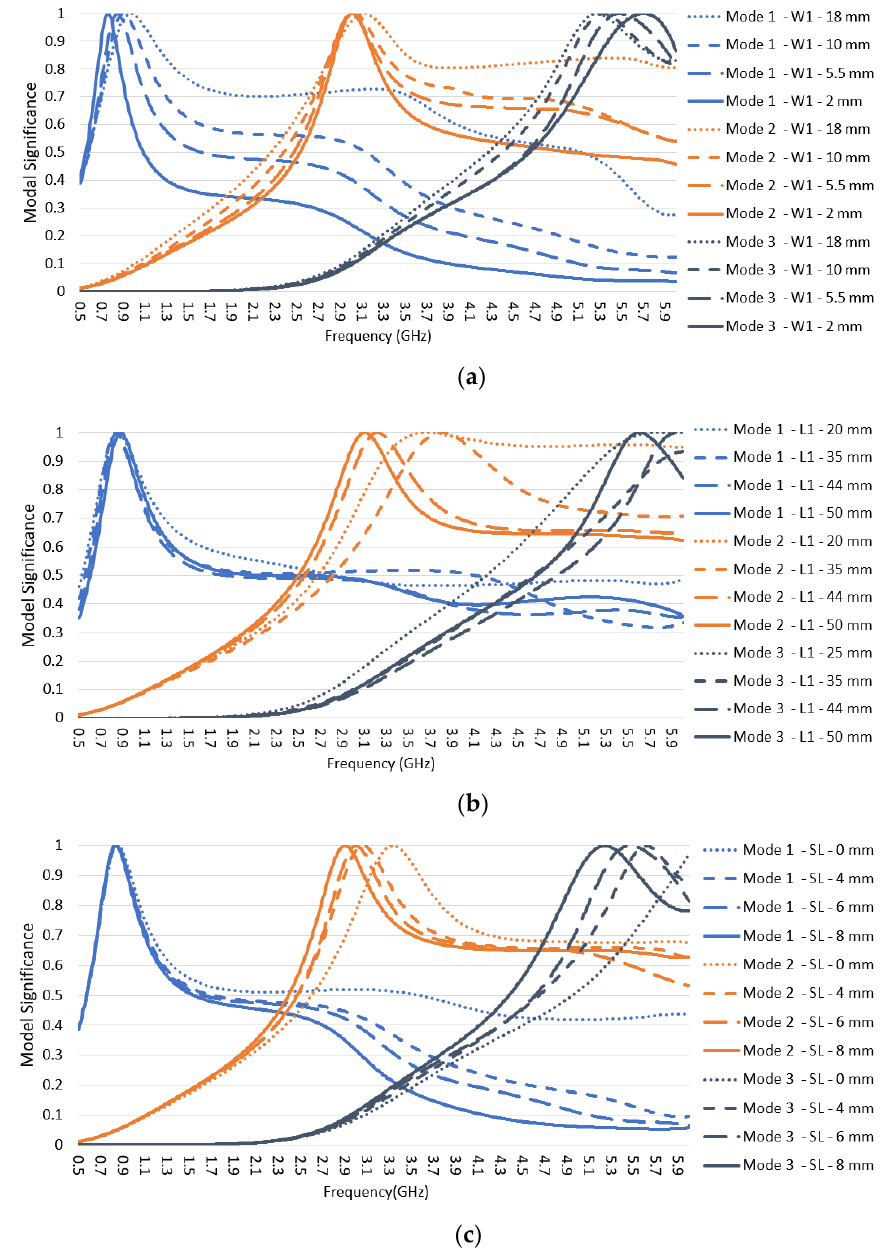
Figure 7. Modal significance for the long-structure while varying three dimensions in Figure 3: ( a ) vertical width W1, ( b ) vertical height L1, and ( c ) slot SL.